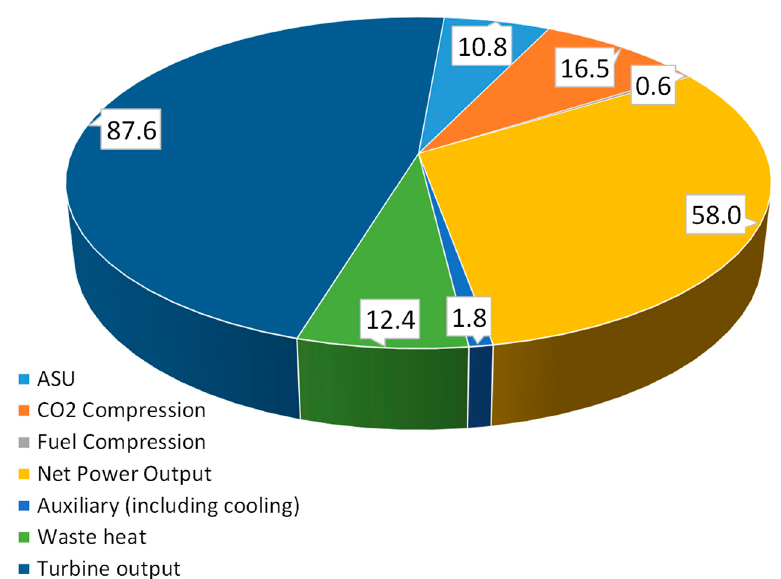
Figure 14. Distribution of the turbine power production in the natural gas-fired Allam cycle.